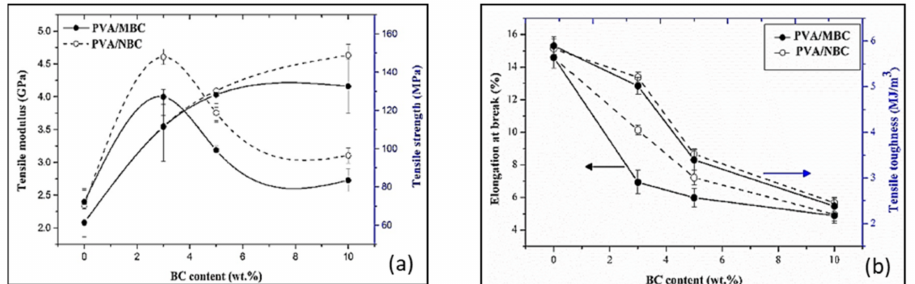
Figure 23. ( a ) Tensile modulus and tensile strength and ( b ) elongation at break and tensile toughness of PVA–NBC and PVA–MBC composites